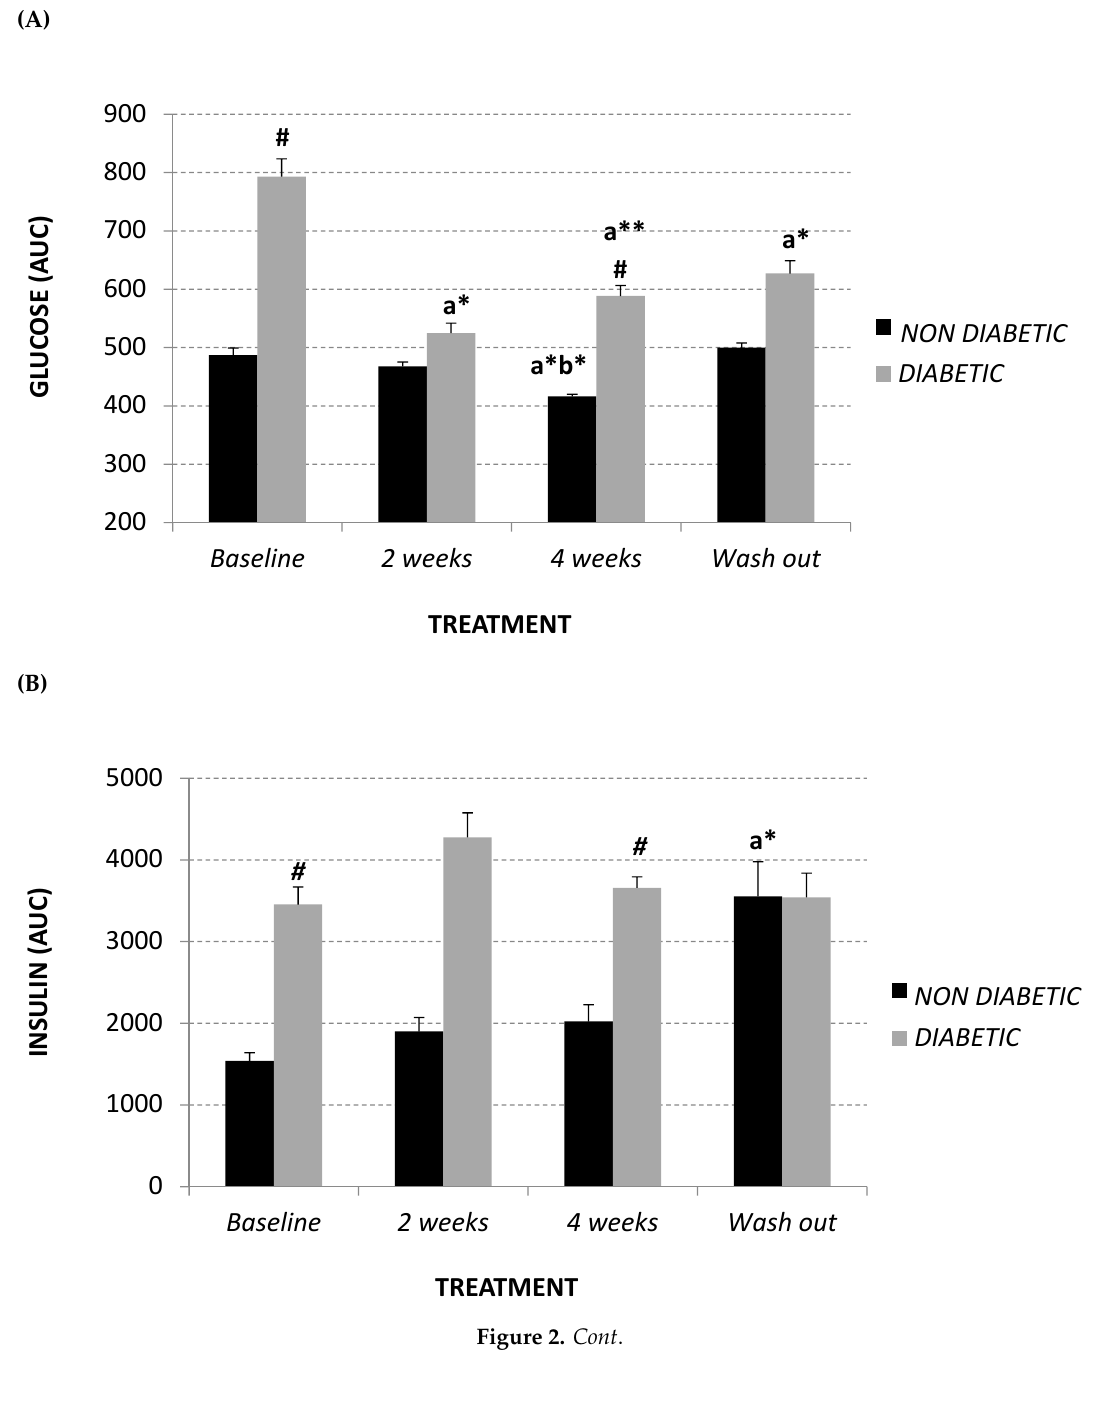
Figure 2. Cont Figure 2. Cont .